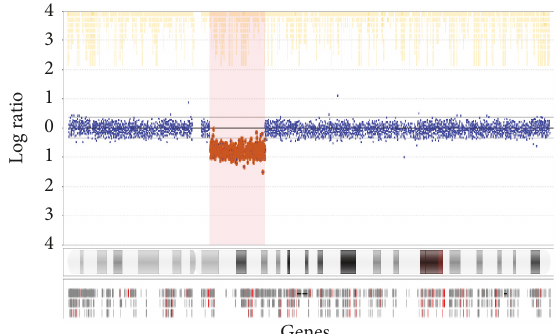
Figure 1: Nimblegen 135K WG CGH v.3.1 microarray, chromosome 4.